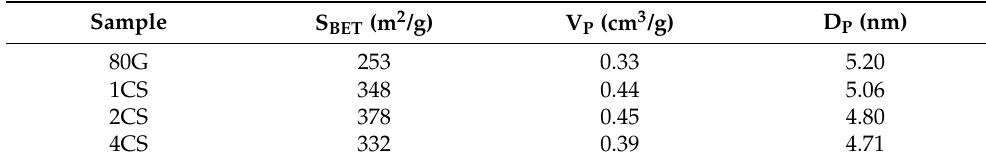
Figure 3. N 2 adsorption–desorption isotherm plots of base glass and co-doped MBG. Table 2. The textural properties of MBG (S BET : specific surface area, V P : pore volume and D P : pore diameter.